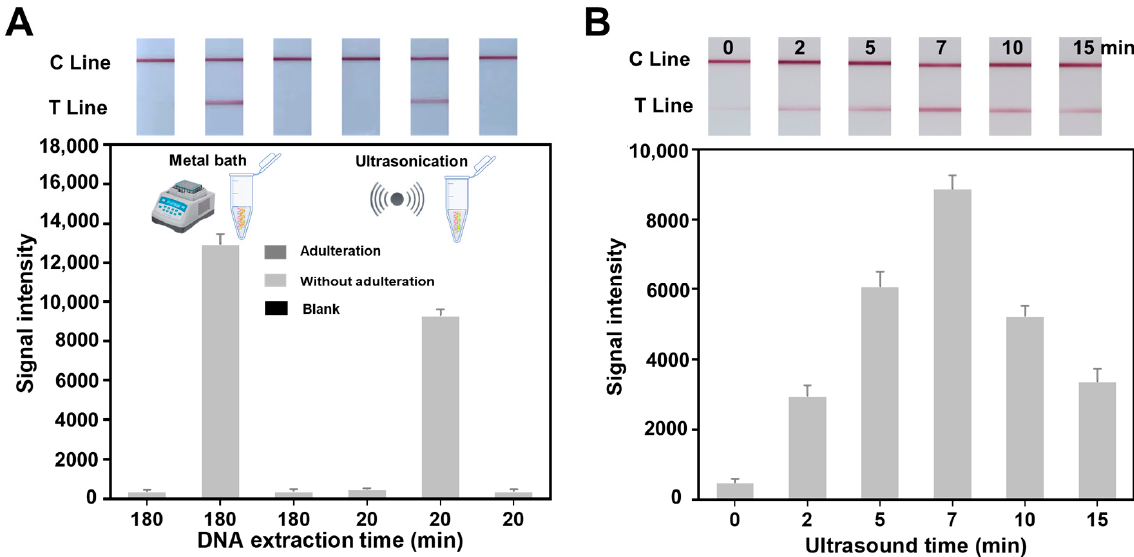
Figure 2. The optimization results of ultrasonic time for pretreatment of honey samples: ( A ) The traditional metal bath method compared with the ultrasonication method for honey genome DNA extraction.; ( B ) Shows the DNA extraction efficiency after different ultrasonication time (0 min, 2 min, 5 min, 7 min, 10 min, and 15 min).